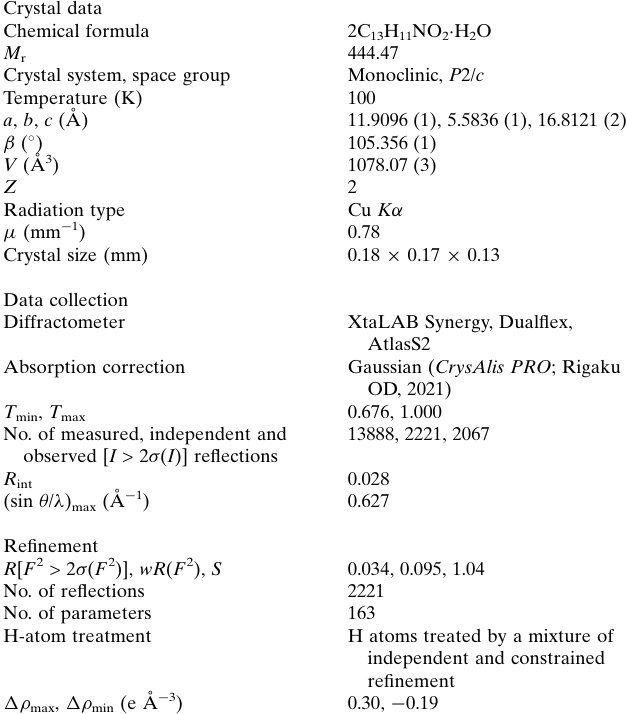
Crystal data Chemical